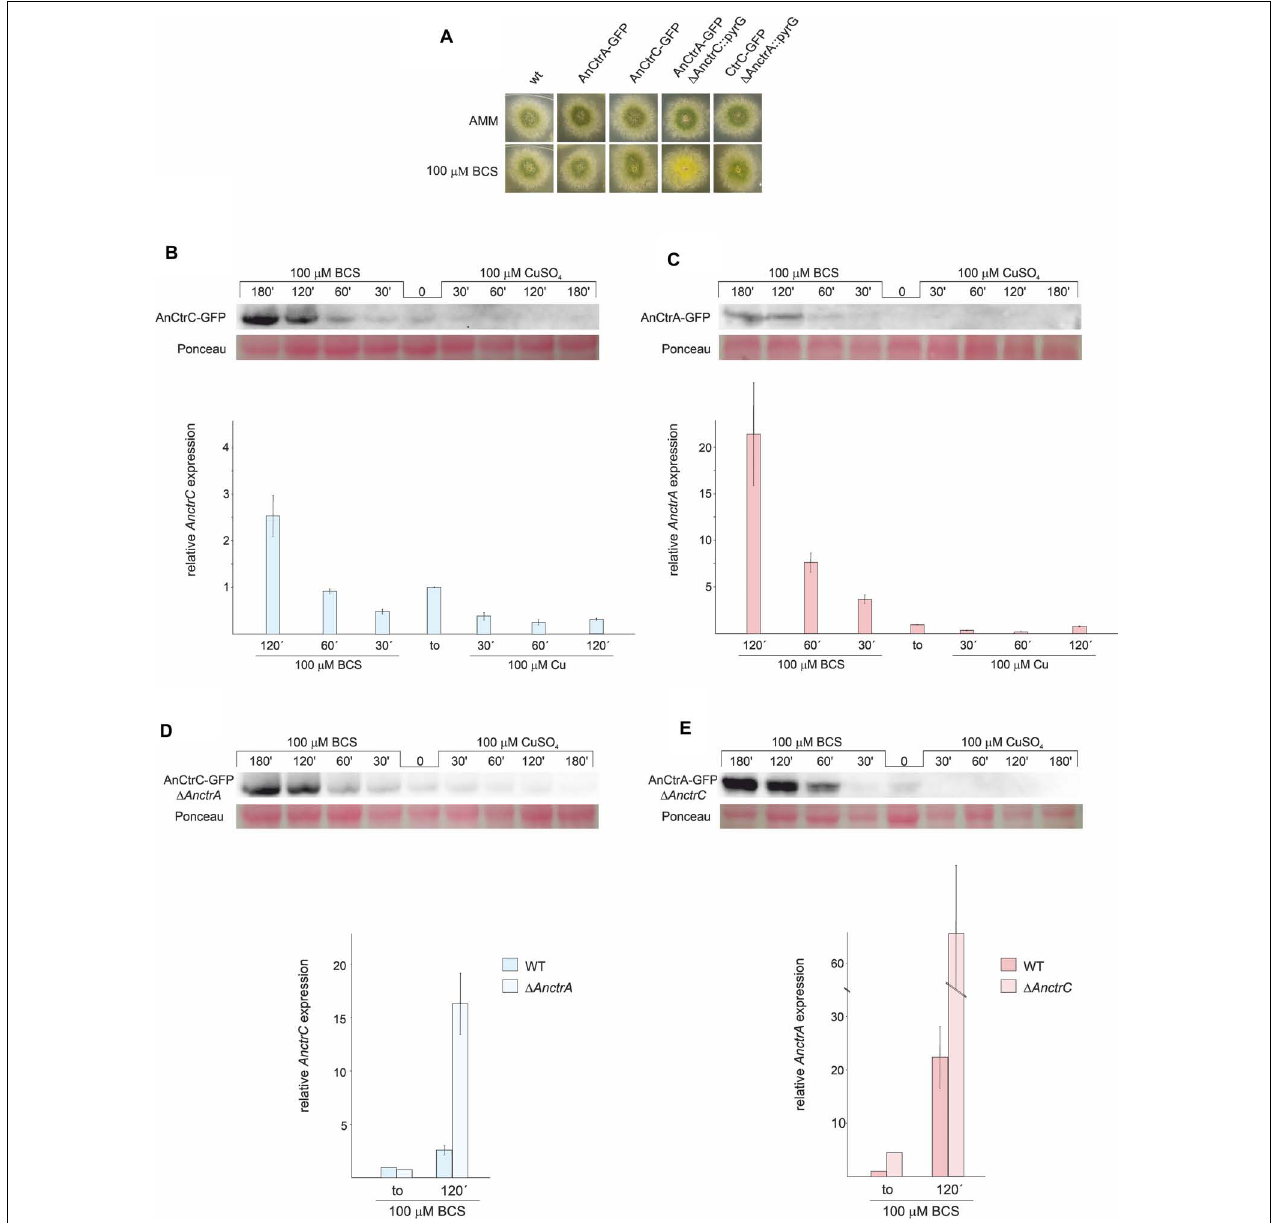
FIGURE 5 | AnCtrC and AnCtrA expression profiles with Cu and BCS. (A) Phenotypes of the strains used for expression analysis of AnCtrC and AnCtrA in AMM and AMM + BCS media. (B) Western Blot and RT-PCR data showing changes in AnCtrC and AnctrC expression levels after addition of 100 µ M CuSO 4 or 100 µ M BCS. (C) Western blot and RT-PCR data showing changes in AnCtrA and AnctrA expression levels after addition of 100 µ M CuSO4 and 100 µ M BCS. (D) Western blot and RT-PCR data showing changes in AnCtrC and AnctrC expression levels in a (cid:49) AnctrA genetic background, after addition of 100 µ M CuSO4 and 100 µ M BCS. (E) Western Blot and RT-PCR data showing changes in AnCtrA and AnctrA expression levels in the (cid:49) AnctrC genetic background, after addition of 100 µ M CuSO4 and 100 µ M BCS.